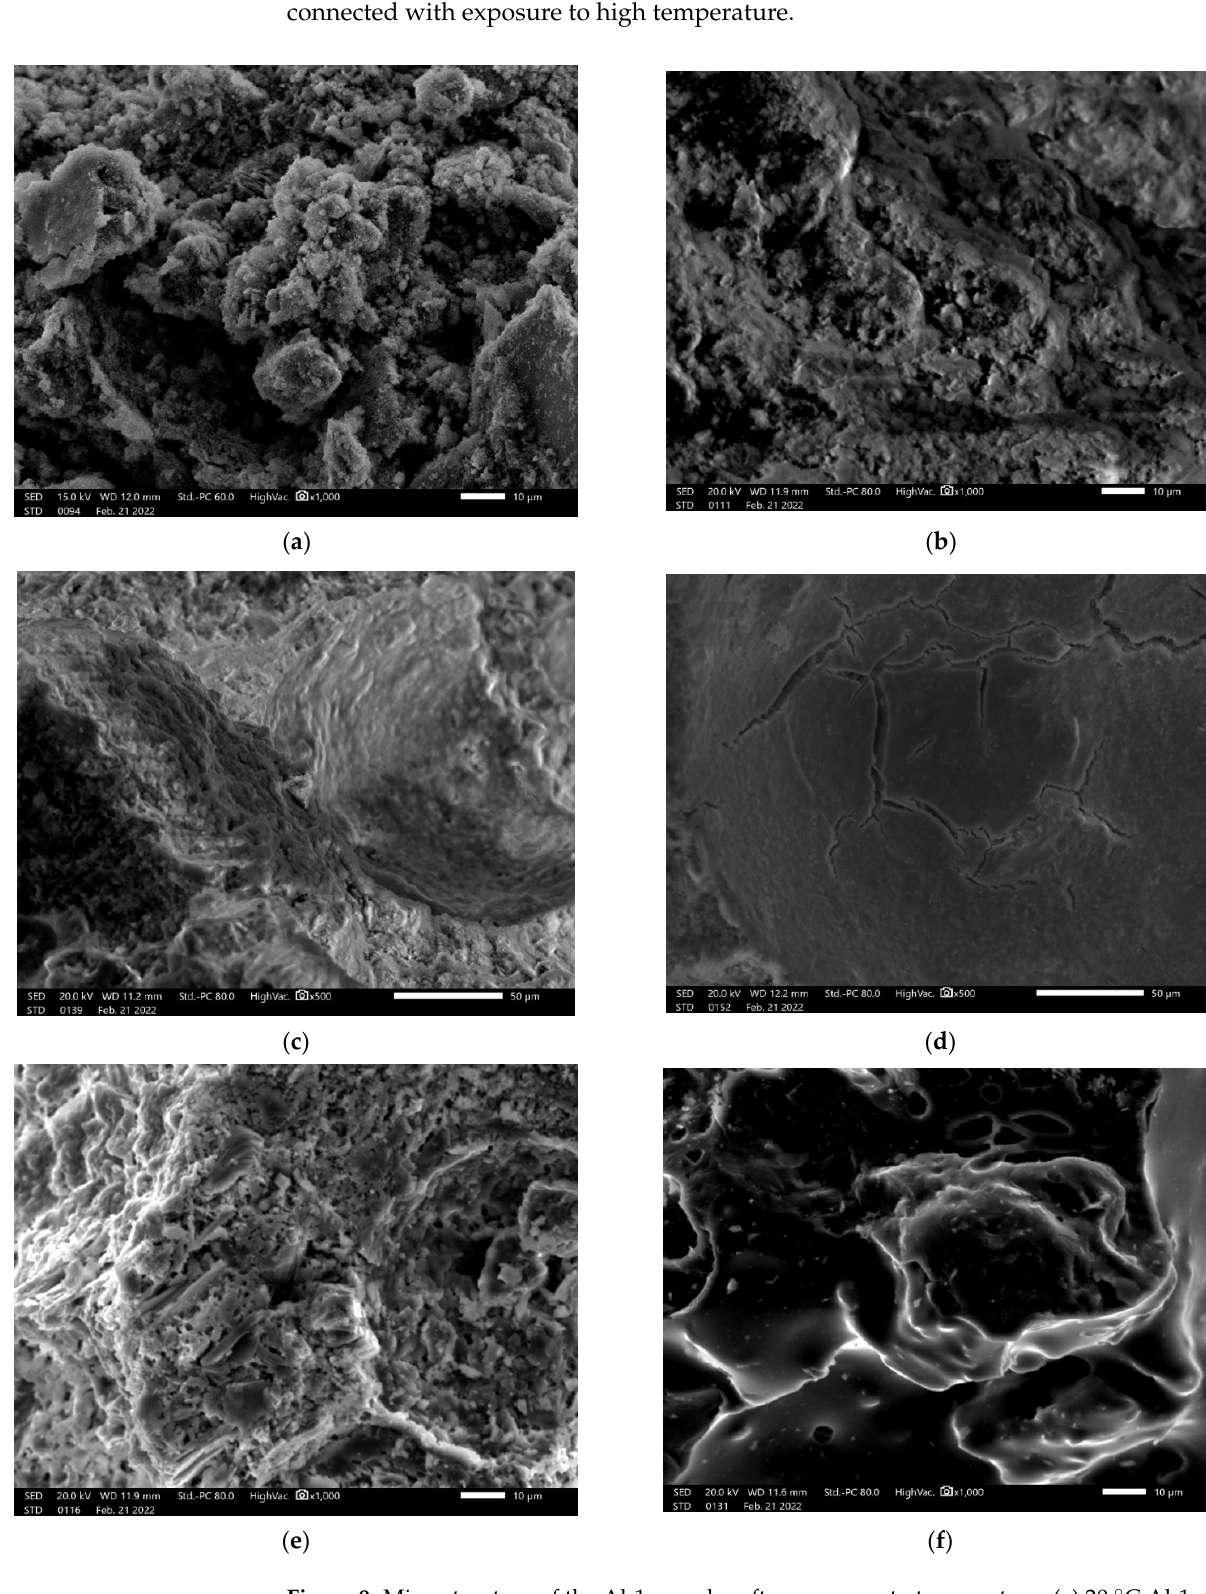
10 of 19 Figure 8. Tensile strength of heated geopolymer foams: absolute values in MPa and relative f tT /f t20 values [-]. It was observed that mechanical behaviour in tension remains quasi-identical for the